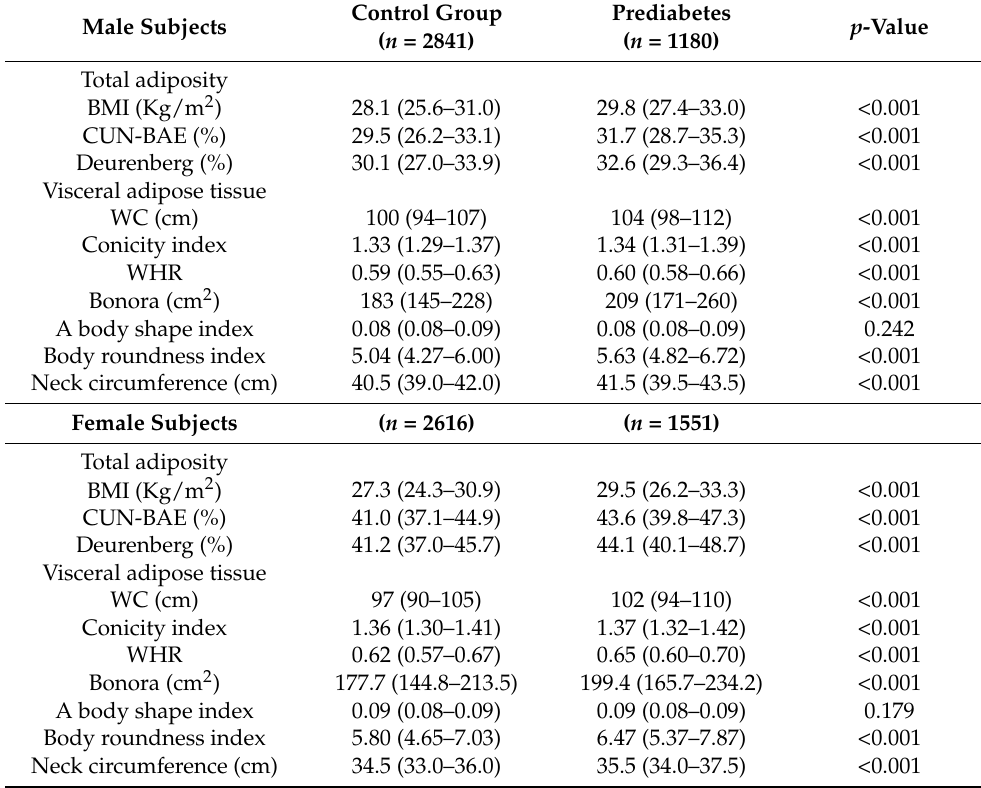
Table 2. Results of the anthropometric indices in male and female participants according to the presence of